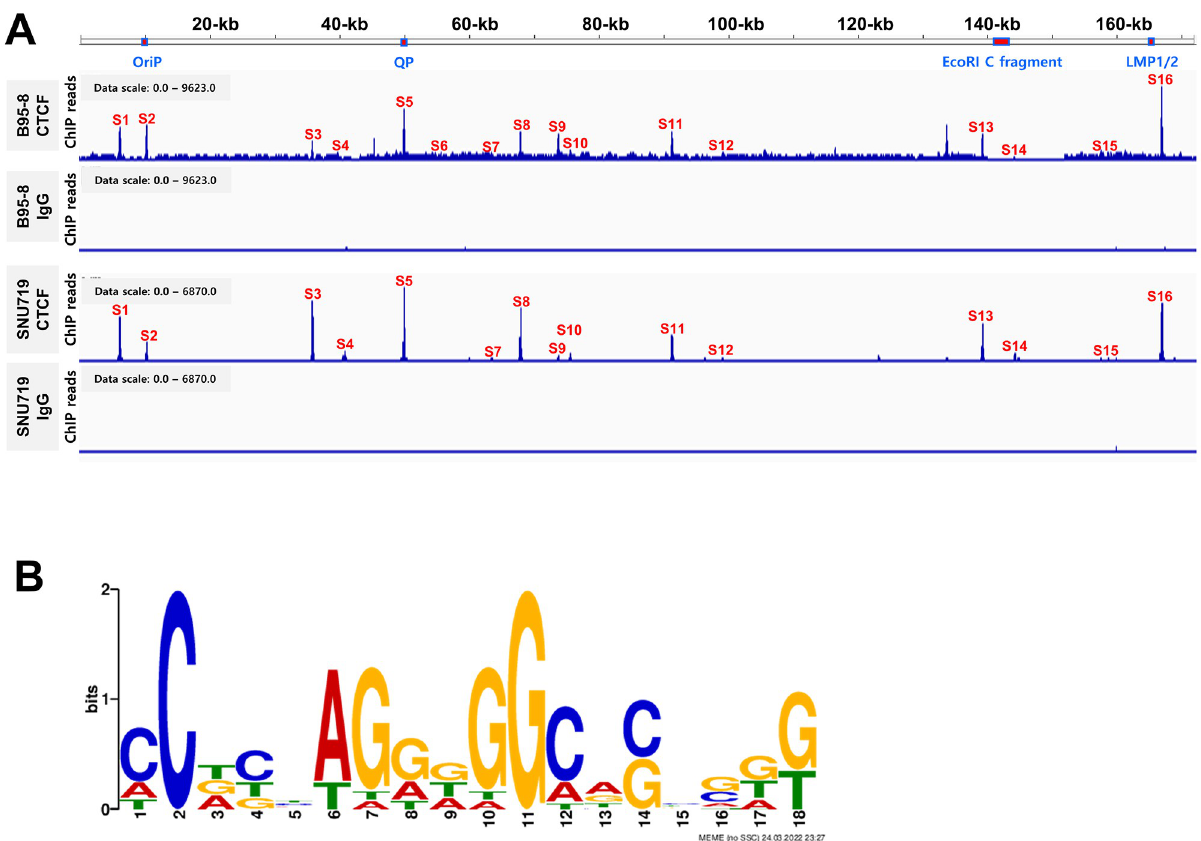
Fig 1. Identification of CTCF binding site on EBV genome in B95-8 and SUN719 cell line. A) CTCF enrichment in EBV genomes of B95-8 and SNU719 cells as determined by CTCF ChIP-seq assays, with IgG ChIP-seq assays performed as negative controls. The mac2 tool was used for peak calling. Next, bigwig files of the ChIP-seq data were applied to Integrative Genomics Viewer (IGV) with EBV reference genome (NC_007605). Resultant peaks were selected and marked as S1 to S16 to indicate CTCF enrichment. B) CTCF Logo. Sequences of S1 to S16 were harvested using IGV and applied to MEME using which a LoGo of CTCF binding sites was